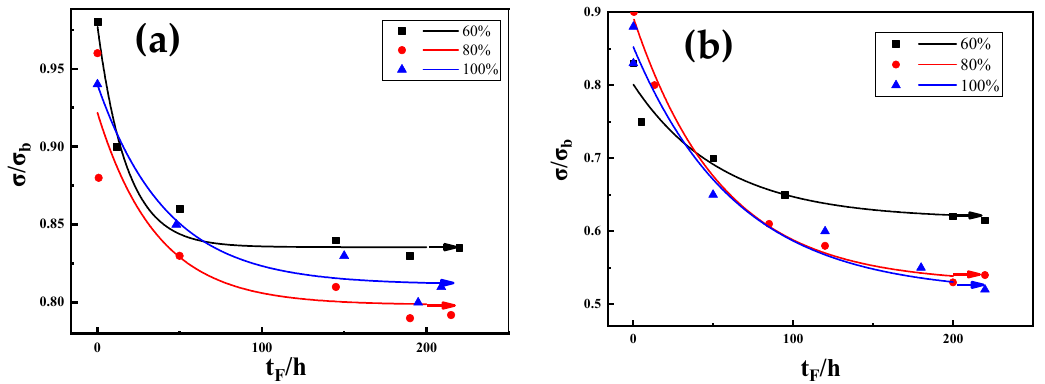
Figure 11. The relationship between applied stress σ / σ b and fracture time t F , ( a ): M7B and ( b ): M10B. The corresponding stress threshold values under di ff erent RH conditions were obtained. Under the conditions of 60% RH, 80% RH and 100% RH, the threshold stress factors were 0.84, 0.8 and